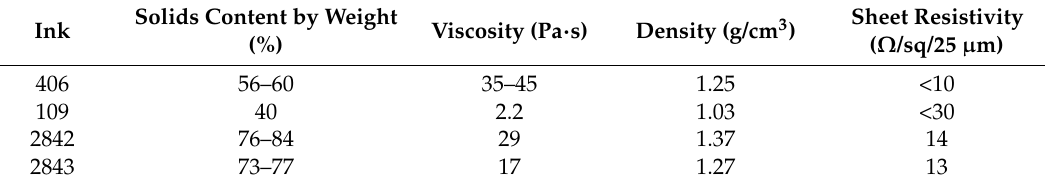
Table 1. Typical characteristic properties of the used inks.